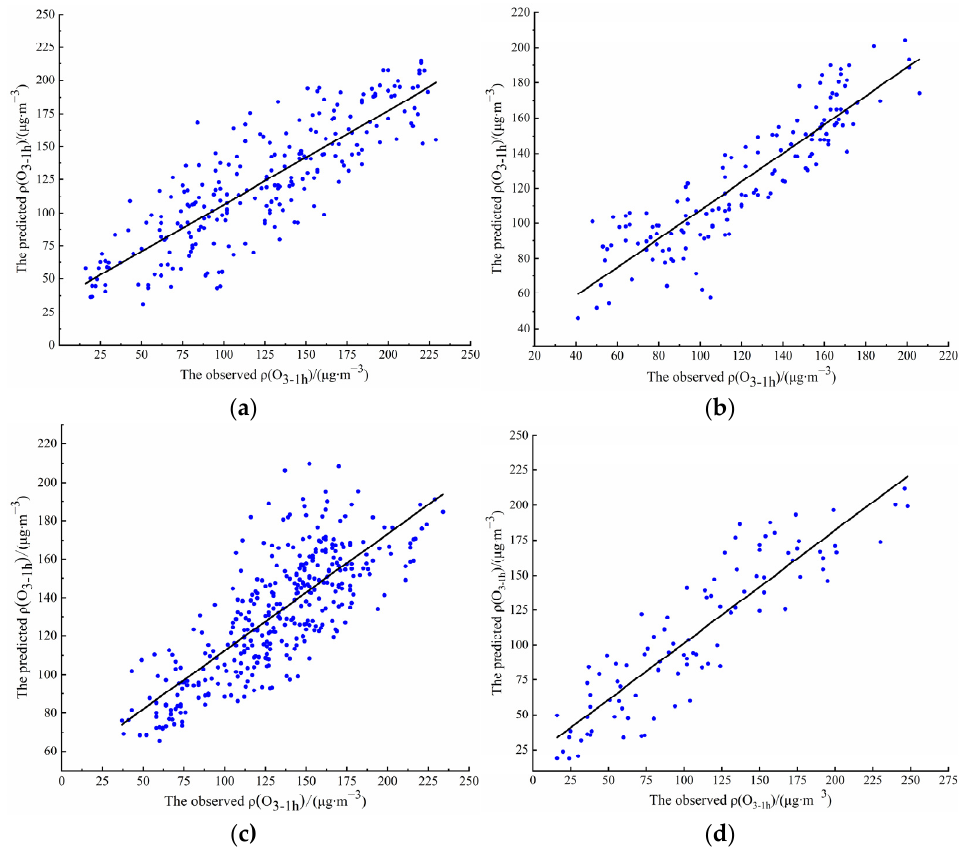
Figure 6. Scatterplots of predicted versus observed O 3 concentrations for the four SWPs. ( a ) Type FS; ( b ) Type GN; ( c ) Type GS ( d ); Type BB. ( b ) Type GN; ( c ) Type GS ( d ); Type